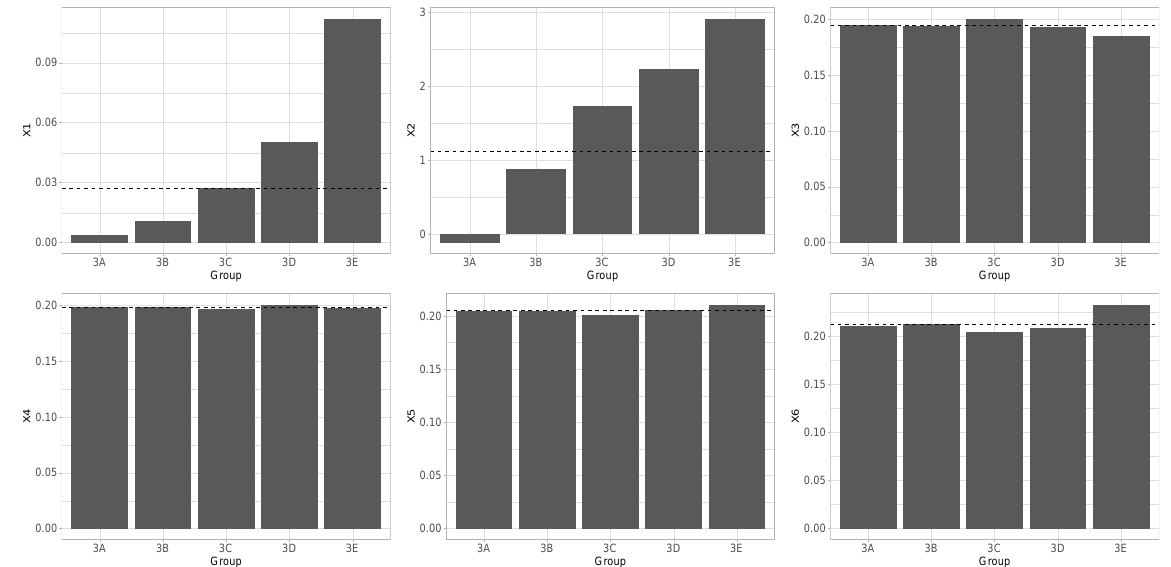
Figure 5. Mean of all covariates used by groups (dashed line for the mean of the whole portfolio).